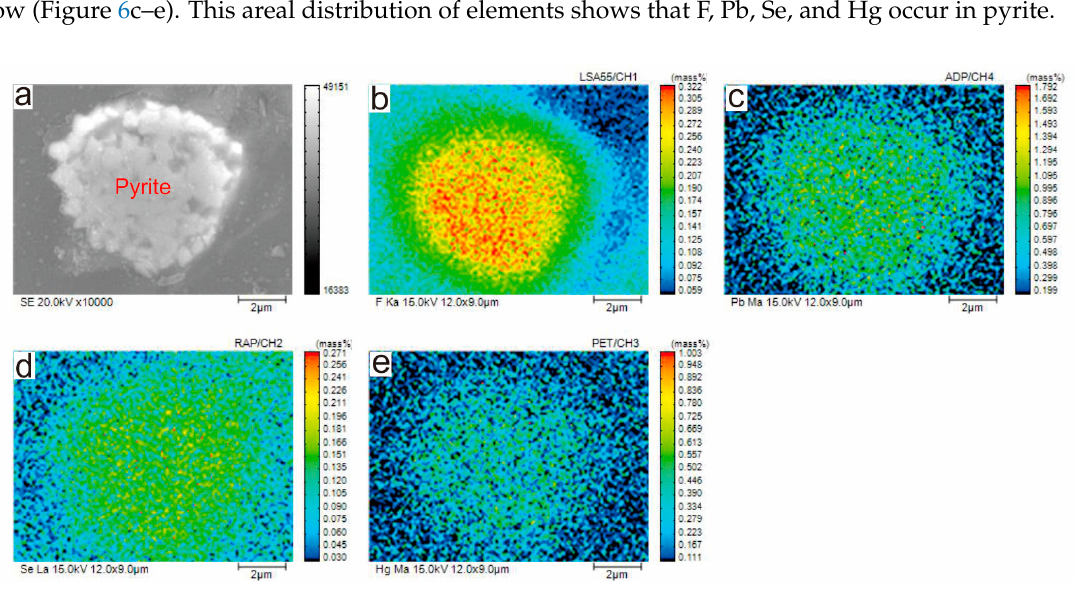
Table 3. EMPA results for the minerals in Figure 5 (%).